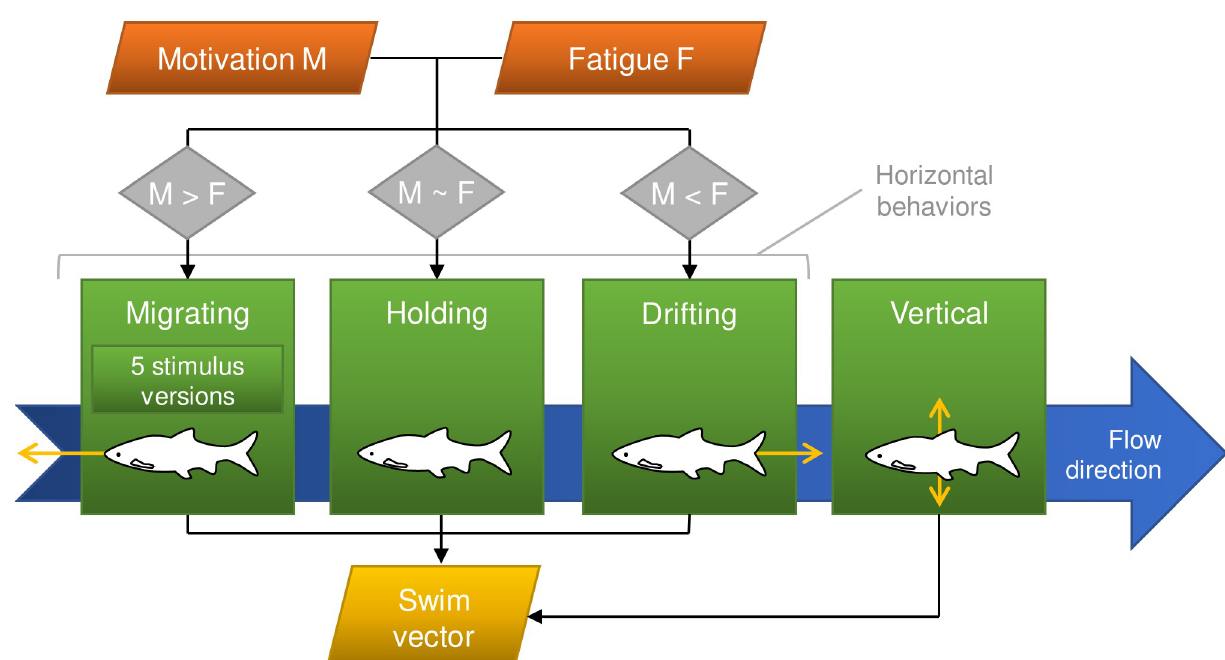
Fig 2. The process of computing the swim vector. Based on the balance between motivation and fatigue, a horizontal behavioral rule is selected. Migrating is the key behavioral rule for which five versions are contrasted. Holding means maintaining the position. Drifting includes swimming against, but slower than the flow. In combination with the vertical behavioral rule, the final swim vector is determined.